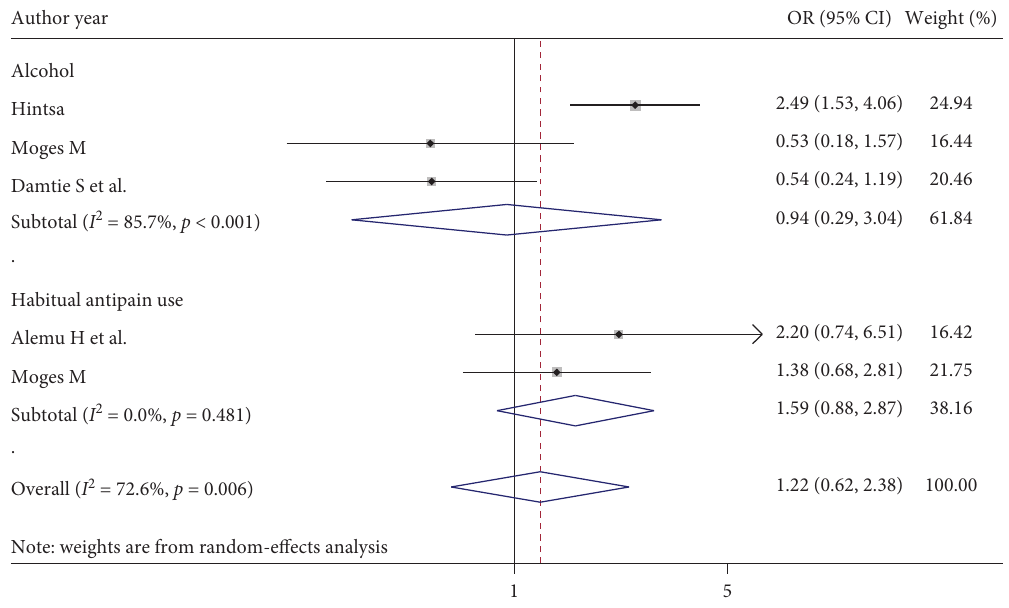
Figure 6: Behavioral factors associated with CKD among diabetes patients.